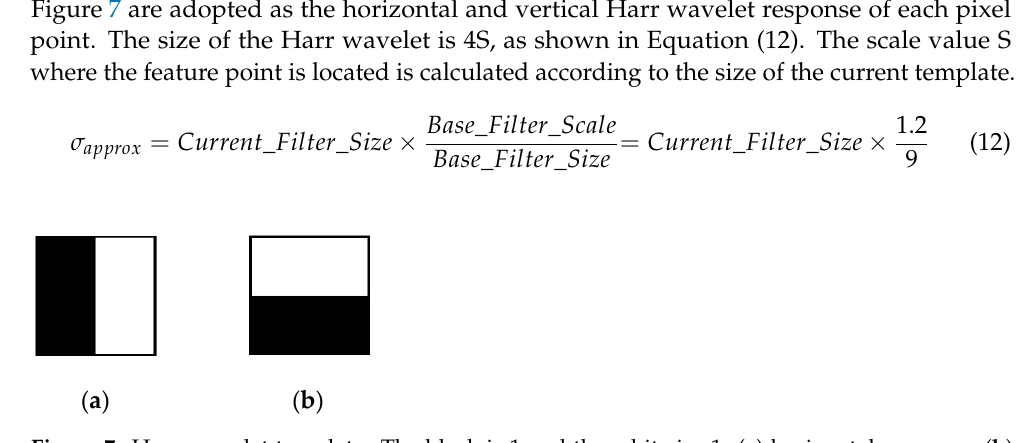
Figure 7. Haar wavelet template. The black is 1 and the white is –1: ( a ) horizontal response; ( b ) vertical response.